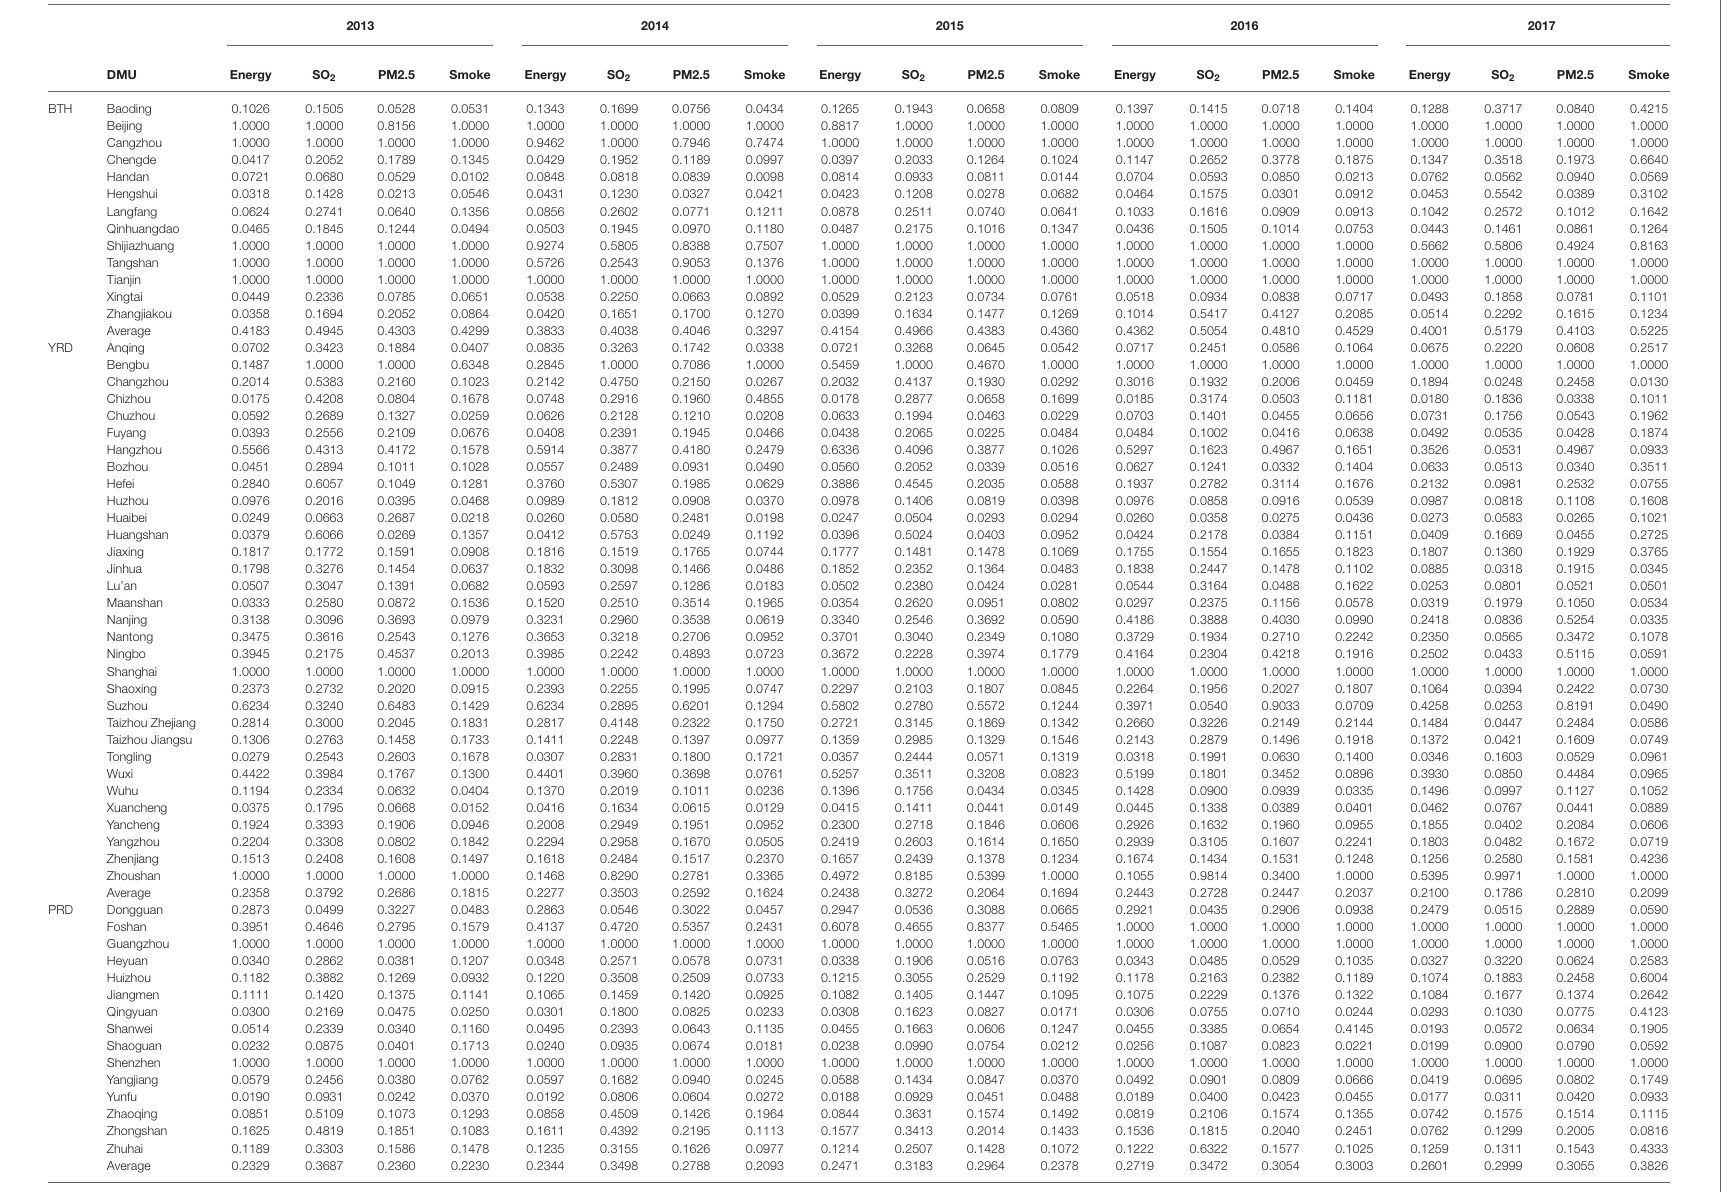
TABLE 6 | Energy consumption per GDP, SO 2 , PM2.5, and industrial smoke and dust